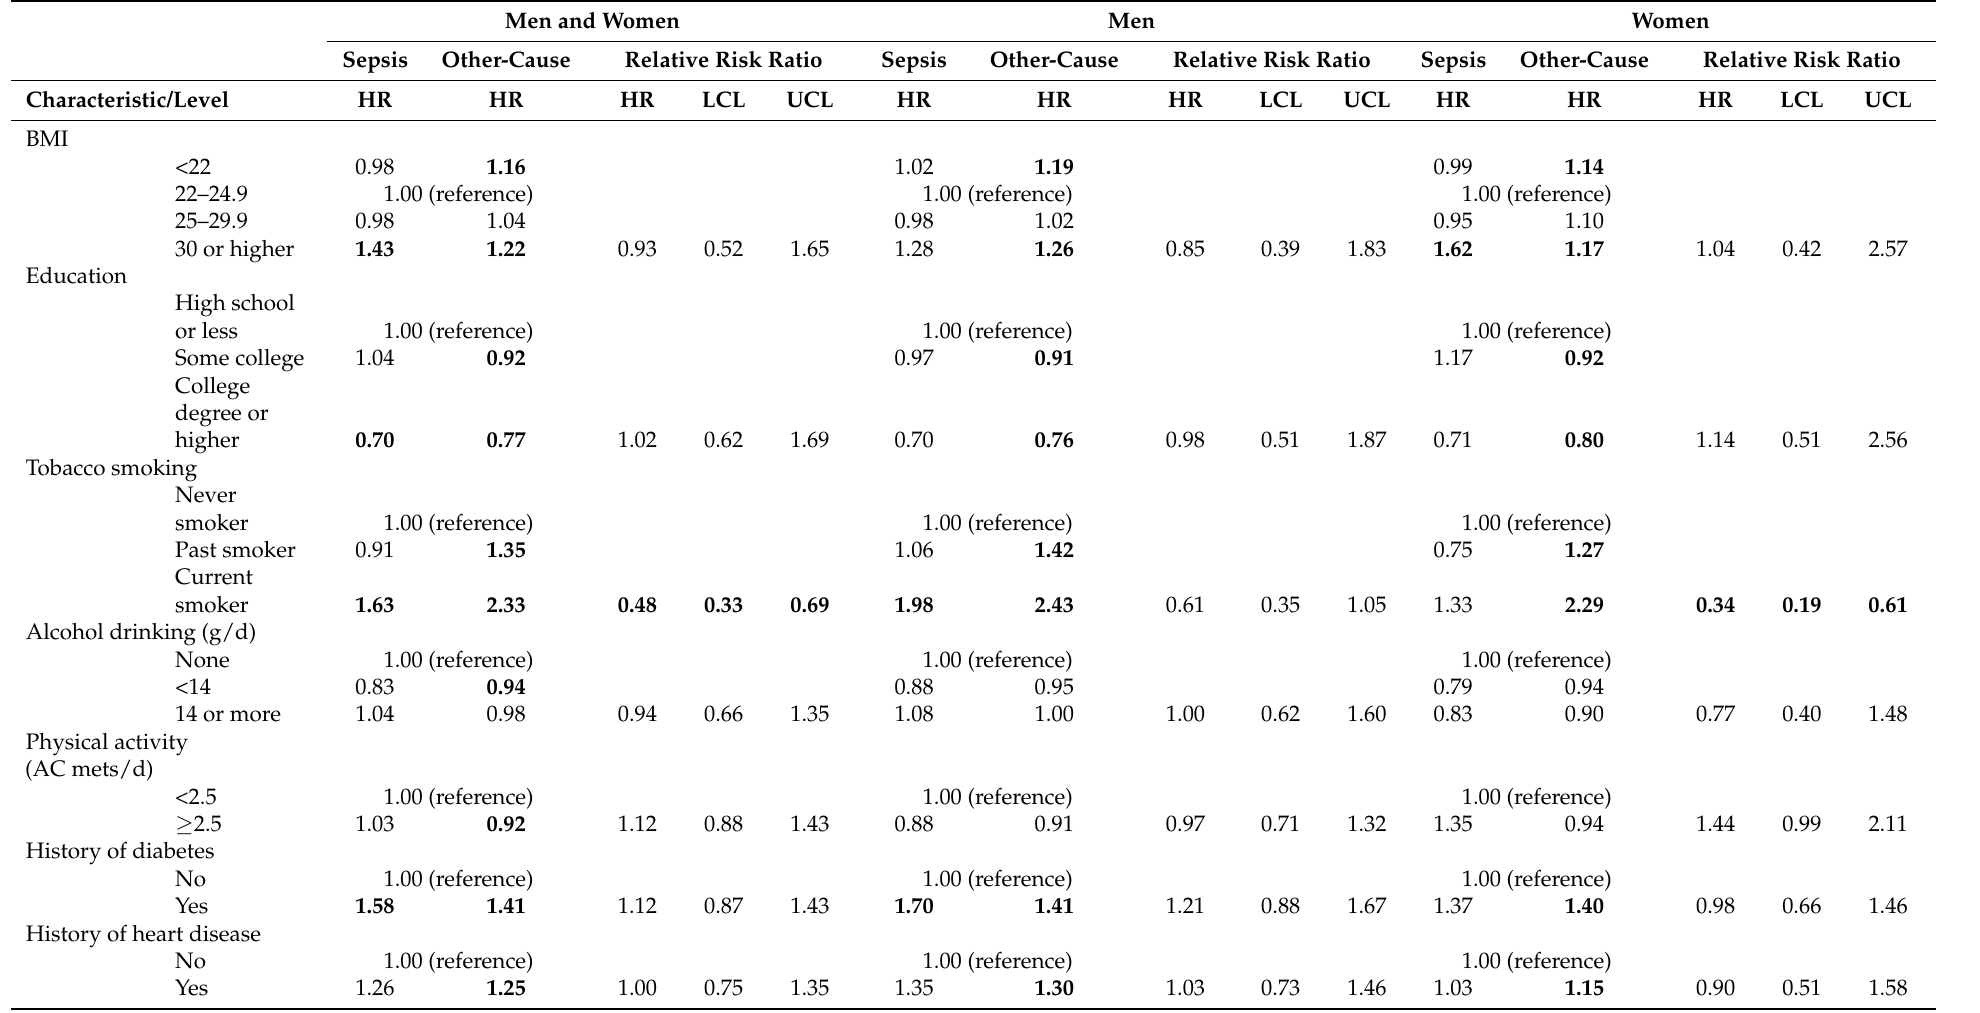
Table 4. Associations of participants’ characteristics with sepsis and other-cause mortality among cancer cases in the Multiethnic Cohort. Men and Women Men Women Sepsis Other-Cause Relative Risk Ratio Sepsis Other-Cause Relative Risk Ratio Sepsis Other-Cause Relative Risk